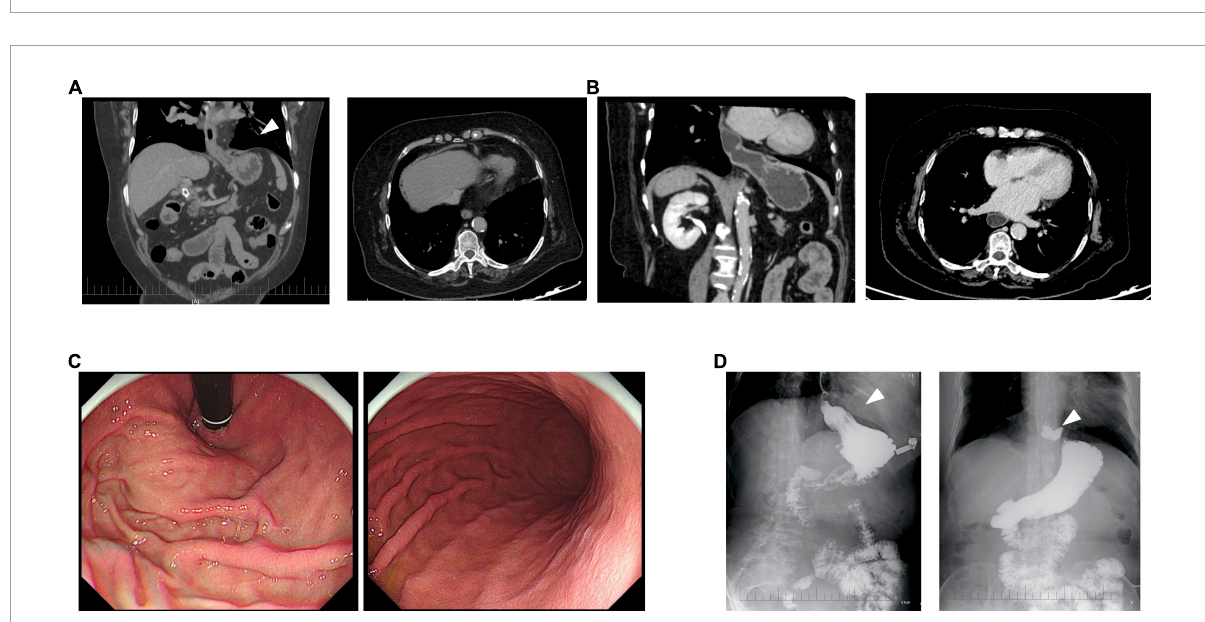
FIGURE4 Clinical diagnosis of immune checkpoint inhibitor (ICI)-related esophageal hiatal hernia. At the sixth (A) and eighth month (B) after the onset of immune-related irAEs, a computed tomography (CT) scan for the first time showed abdominal viscera protruding into the left hemithorax (arrow). Upper gastroenterography and endoscopy showed no esophagitis and inflammation of the gastric body and antrum (C) , but a clinically confirmed diagnosis of sliding hiatal hernia of the esophagus (type I) was made (arrow) (D)